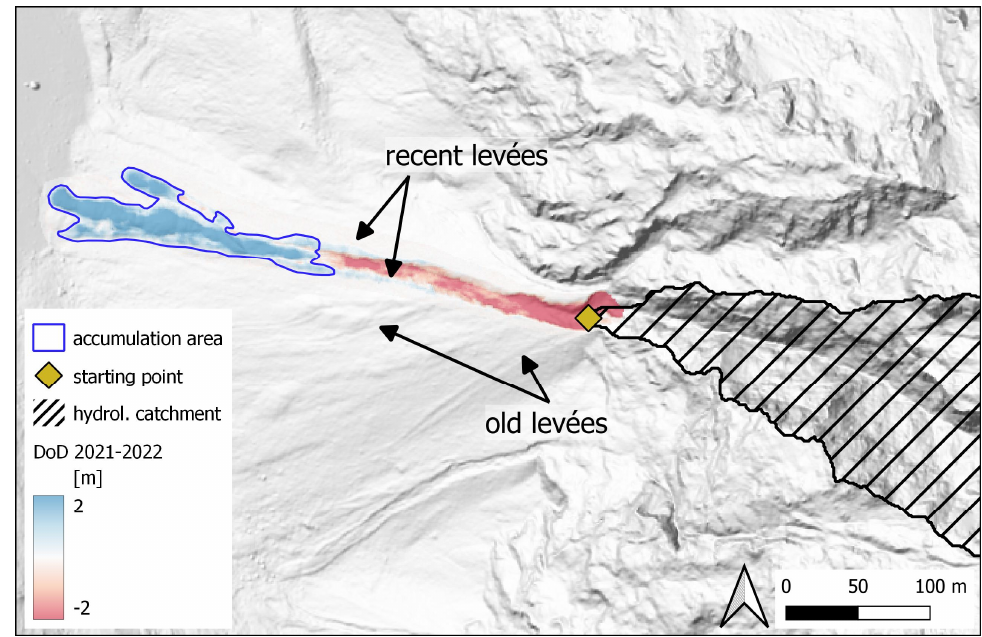
Figure 9. Example of a detected debris flow in LT (E: 653275, N: 5220945 (EPSG: 25832)) based on the DoD.